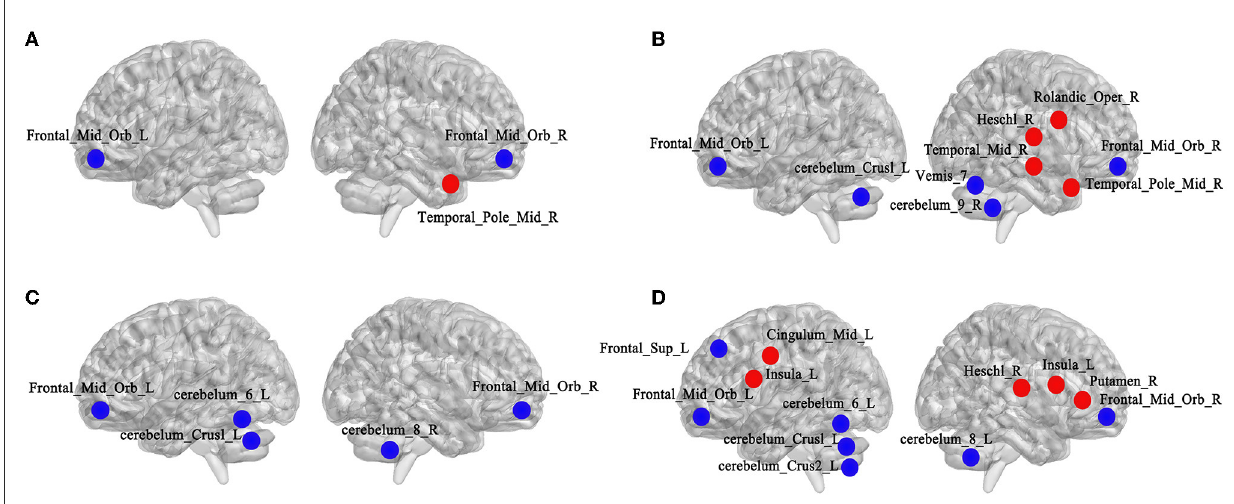
FIGURE5 Comparisons of node attribute indicators of functional brain networks from the AAL160 template. (A) Altered brain regions of Ne between the NCs and LLD baseline groups (left side is left hemisphere, right side is right hemisphere, red for attribute enhancement, blue for attribute reduction); (B) Altered brain regions of DC between the NCs and LLD baseline groups; (C) Altered brain regions of Ne between the LLD baseline and LLD follow-up groups; (D) Altered brain regions of DC between the LLD baseline and LLD follow-up